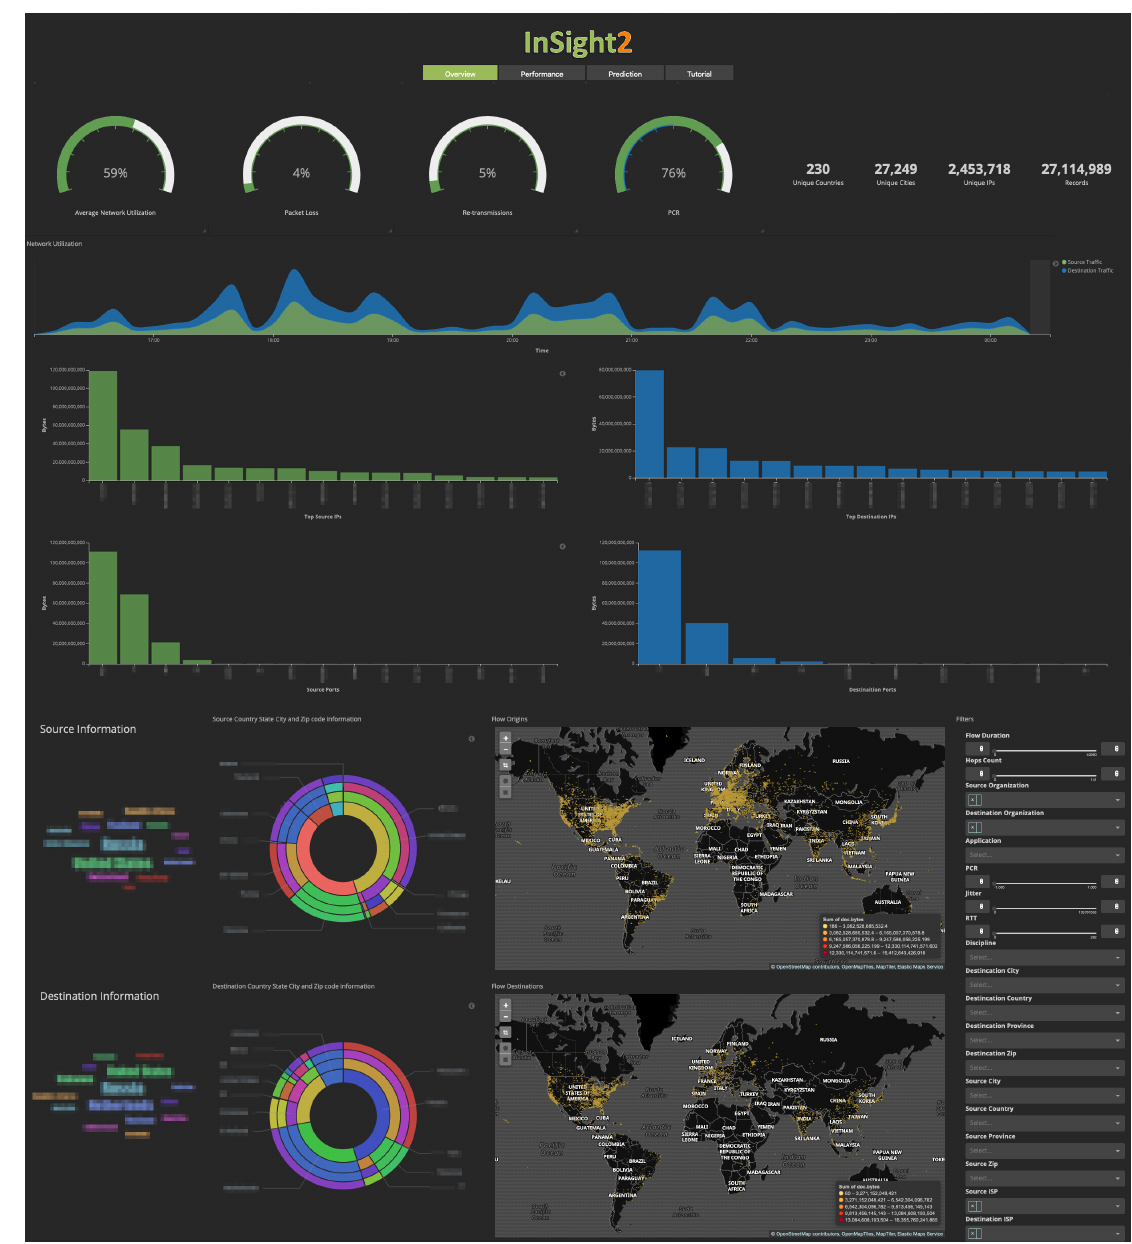
Figure 5. Network traffic overview